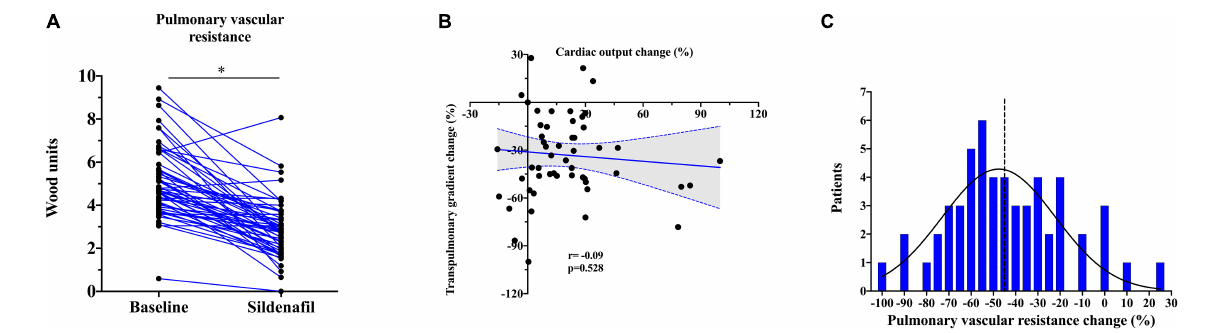
FIGURE 1 | (A) Changes in pulmonary vascular resistance (PVR) after acute PDE5i administration. The asterisk stands for p < 0.001. (B) Correlation between relative transpulmonary and cardiac output change after PDE5i infusion. (C) Distribution of sildenafil response in terms of PVR in our sample. The dashed line represents the